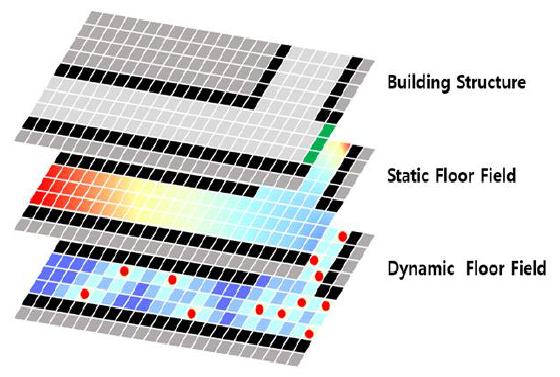
Figure 2. The structure of FFM